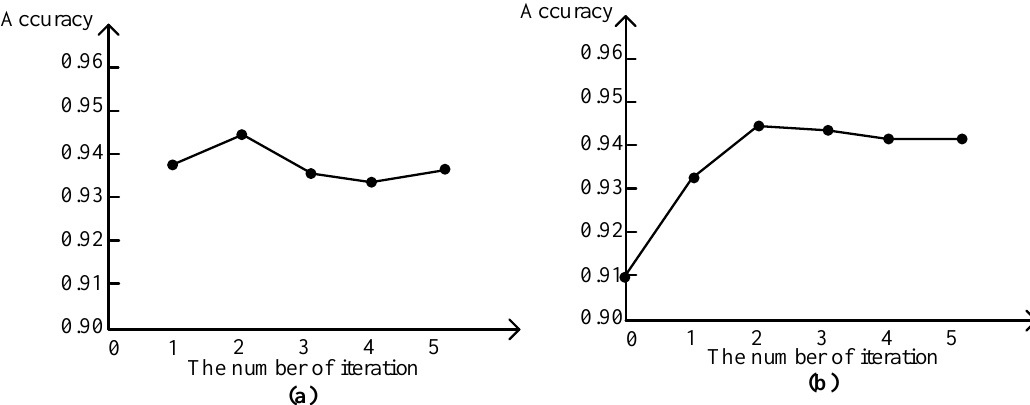
Figure 10. ( a ) Accuracy of label propagation during the iteration. ( b ) Accuracy of classification during the iteration.